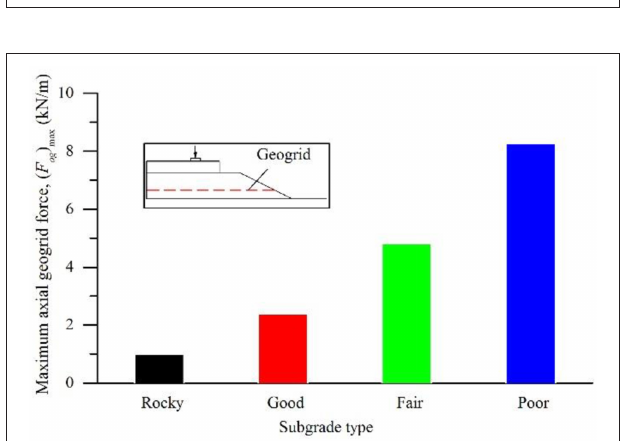
FIGURE 3 | Maximum axial forces in geogrids over different subgrades in the reinforced models (Case 1).